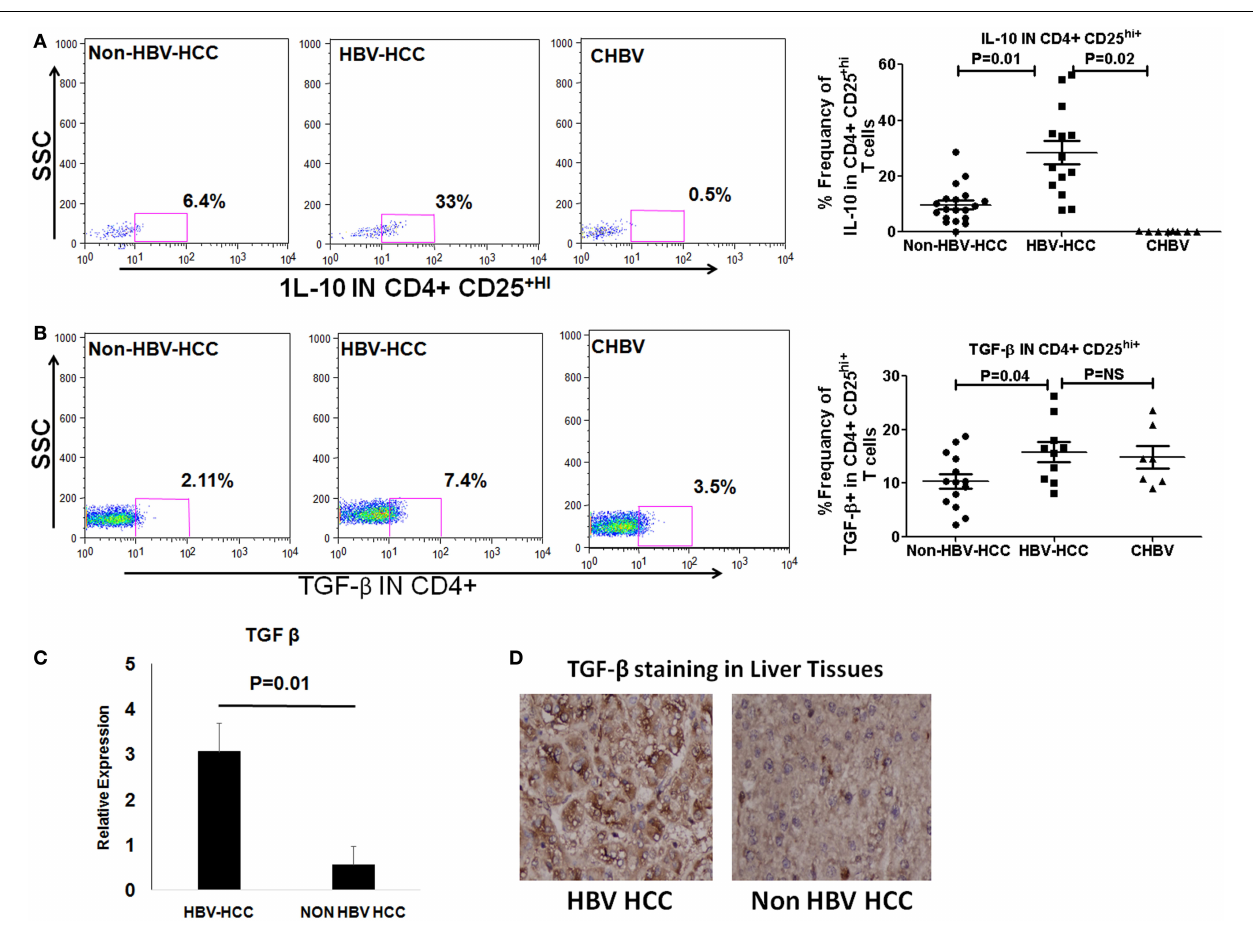
analysis confirmed the overexpression ofTGF- β in HBV-HCC than non-HBV-HCC. (D) Immunohistochemistry analysis also confirmed the over expression ofTGF- β in HBV-HCC than non-HBV-HCC liver tissues. 40 × magnification was used.